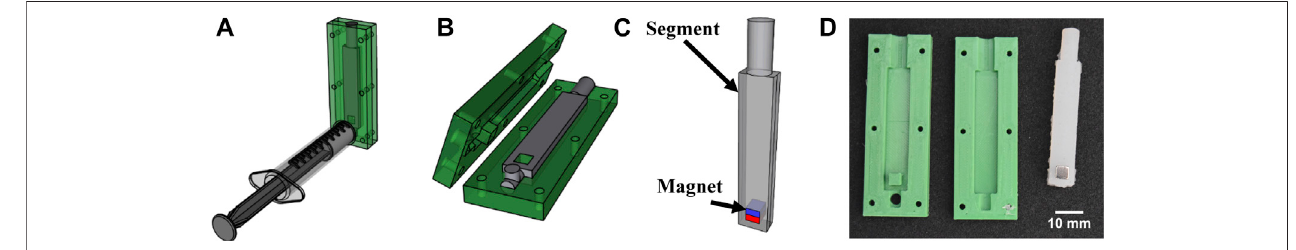
FIGURE 3 | Fabrication steps for magnetic robots are shown: (A) injection of the silicone in the negative mold; (B) curing of the silicone; (C) magnet insertion (D) image of the mold and sample.